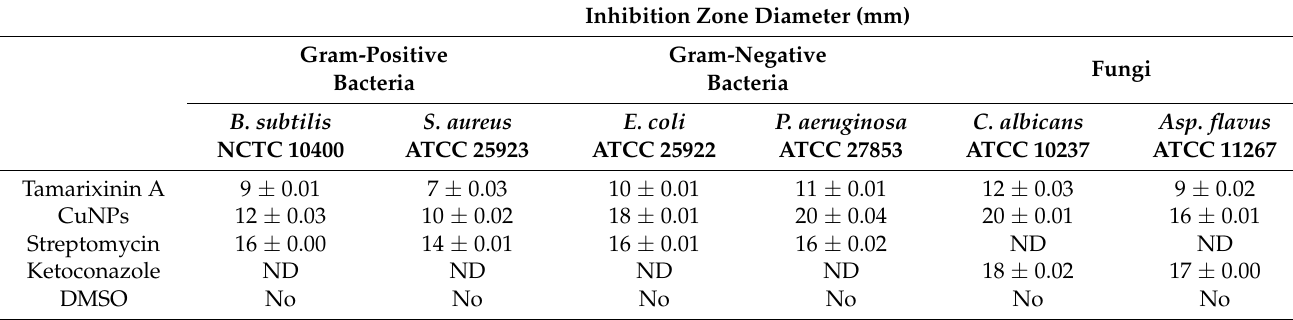
Table 1. In vitro antimicrobial activity (average diameters of inhibition zones) of TA and its mediated CuNPs against different bacterial and fungal